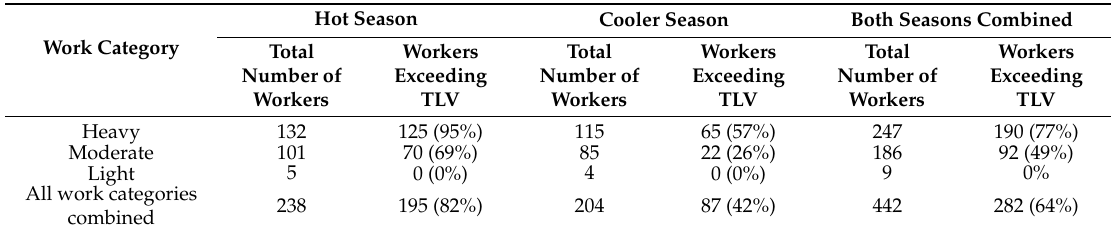
Table 2. Seasonal distribution of workers exceeding ACGIH recommended threshold limit values in various work intensity categories.